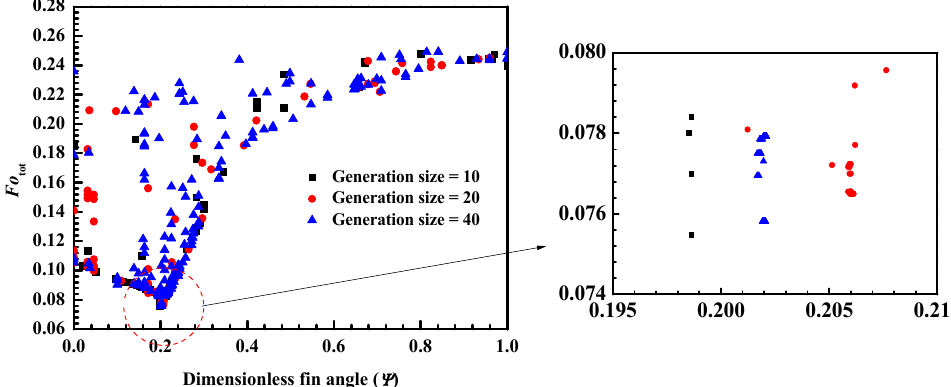
Figure 5. Different dimensionless fin lengths generated by genetic algorithm (GA) with different population sizes.